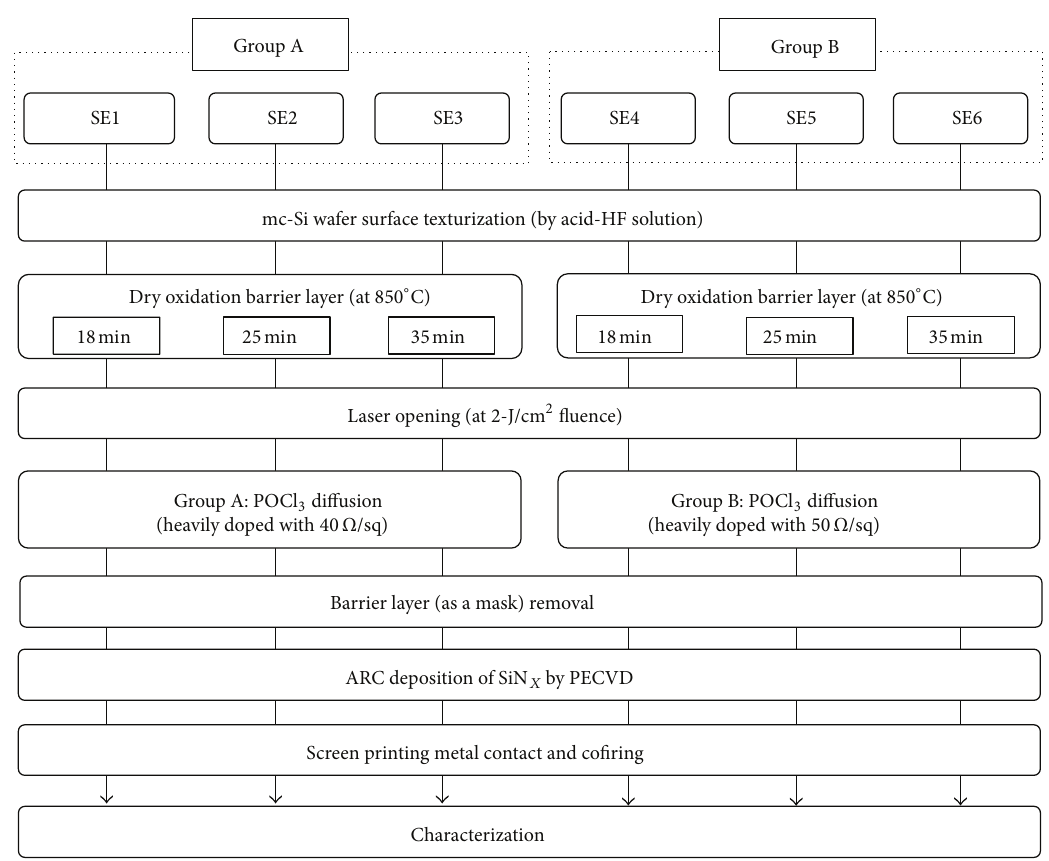
Figure 1: Fabrication procedure for six SE samples prepared to investigate the effects of dry oxidation duration and one-step POCl 3 diffusion on solar cell performance. The heavily doped regions and lightly doped regions were formed simultaneously with one-step POCl 3 diffusion.